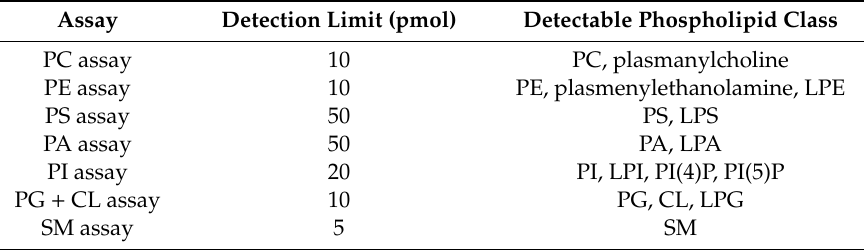
Table 1. Sensitivities and specificities of enzymatic fluorometric